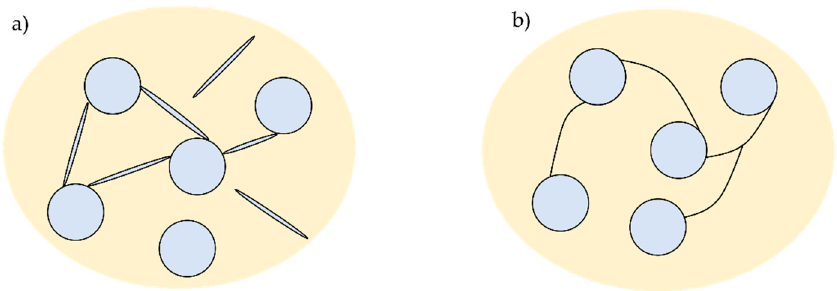
Figure 1. The illustration of proposed models of porous-cracked limestone: ( a ) double porosity model (Type 1 model), ( b ) f -model (Type 2 model).